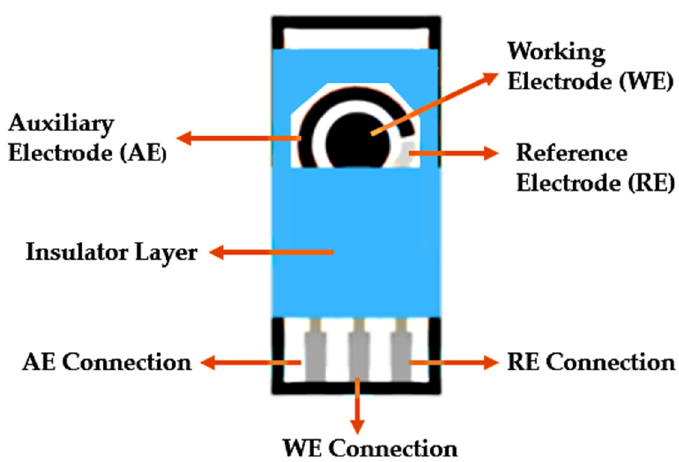
Figure 9. Typical design of an electrochemical biosensor produced by screen printing [109].